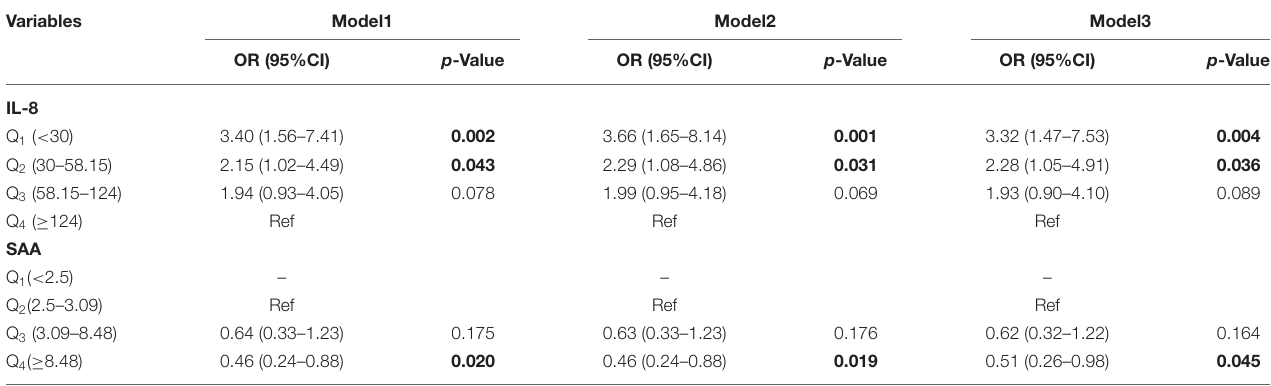
TABLE 3 | Odds ratios (95%CI) of anxiety symptoms associated with IL-8 and SAA. Variables Model1 Model2 Model3